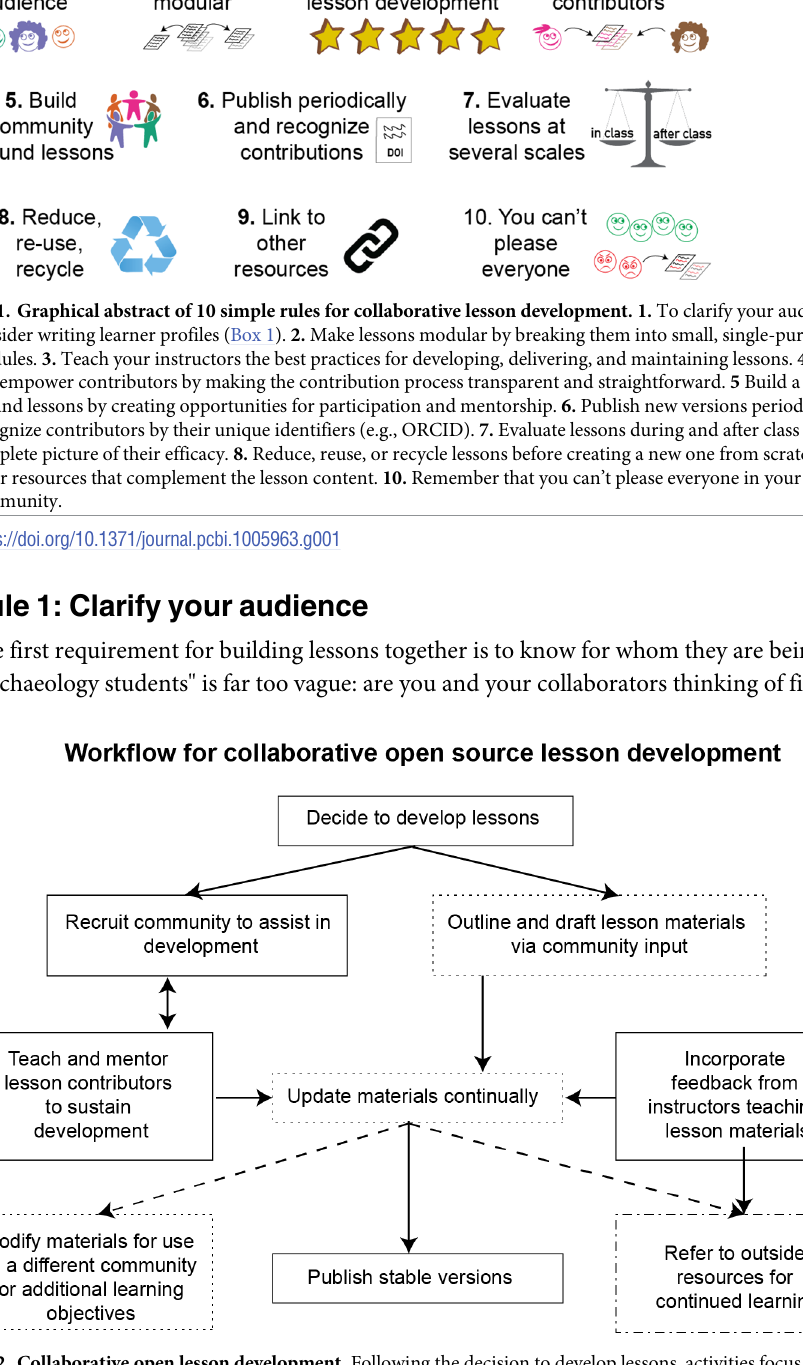
Fig 2. Collaborative open lesson development. Following the decision to develop lessons, activities focus on lesson development as well as community building. Boxes surrounded by dotted lines represent community contributions to lessons. Dashed arrows represent connections to activities outside the original lesson design. The box enclosed in a dashed dotted line represents unaffiliated learning resources.